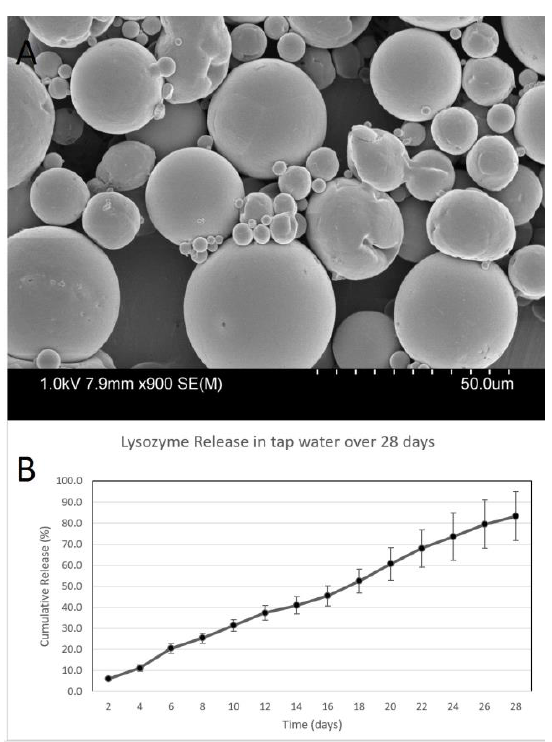
Figure 2. Characterization of lysozyme-releasing microspheres. ( A ) Scanning electron microscopy images of microspheres. ( B ) Graph showing the cumulative release of lysozyme over 28 days with error bars representing the cumulative standard deviation at each time interval ( n = 3).